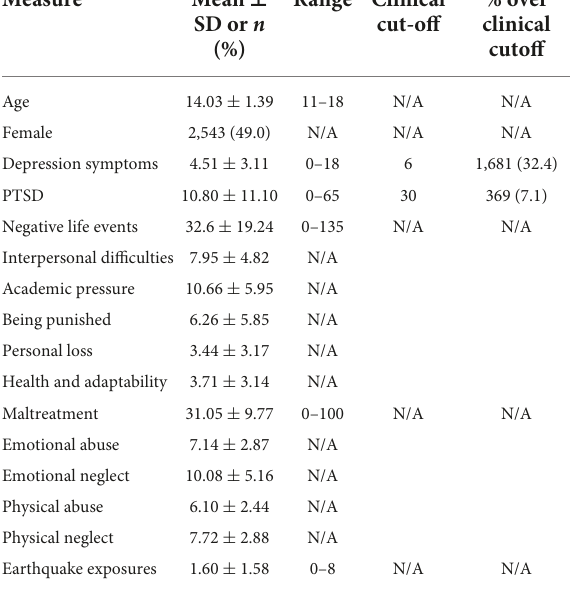
TABLE 1 Descriptive statistics for post-traumatic psychological evaluations from Chinese adolescents experiencing multiple difficulties ( N =